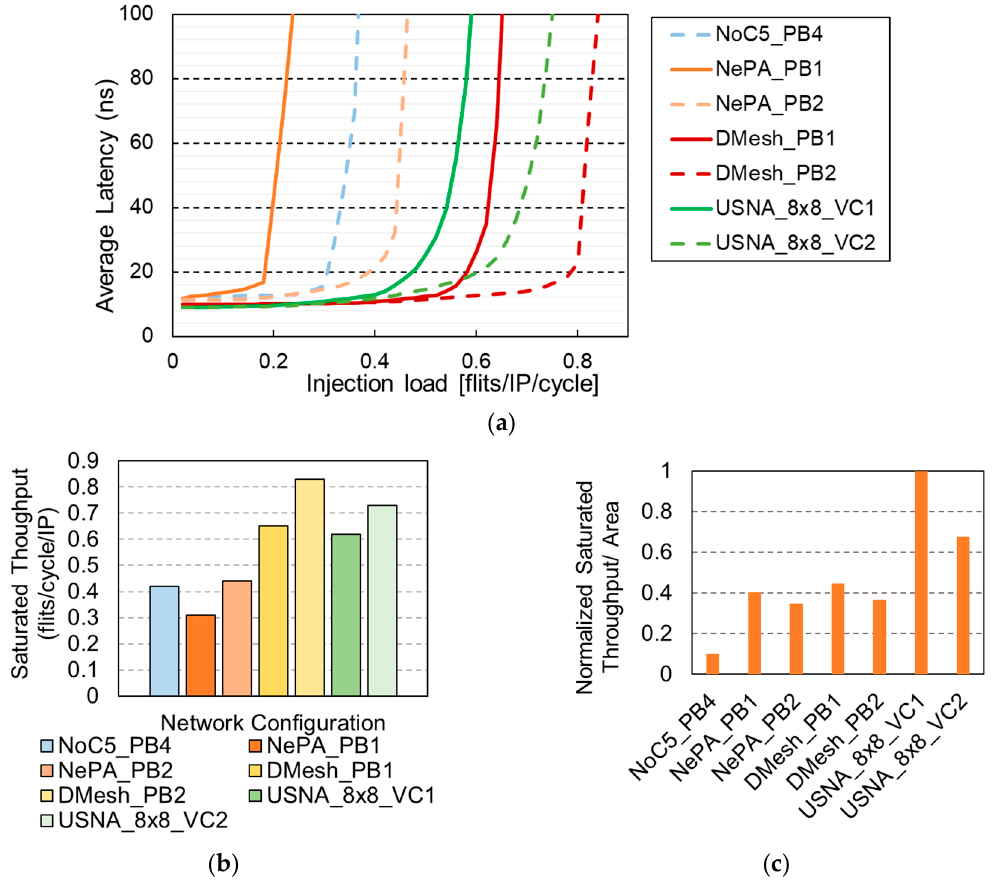
Figure 9. Performance comparison of NoC5, NePA, DMesh, and USNA under uniform random traffic: ( a ) average latencies, ( b ) saturated throughputs, and ( c ) normalized saturated throughput/area. Table 4. Comparison of area and maximum frequency.